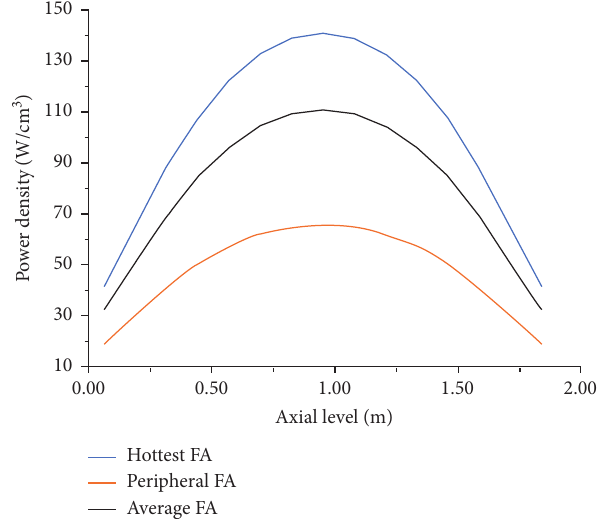
Figure 6: Axial power distribution at BOC for different flow channels.